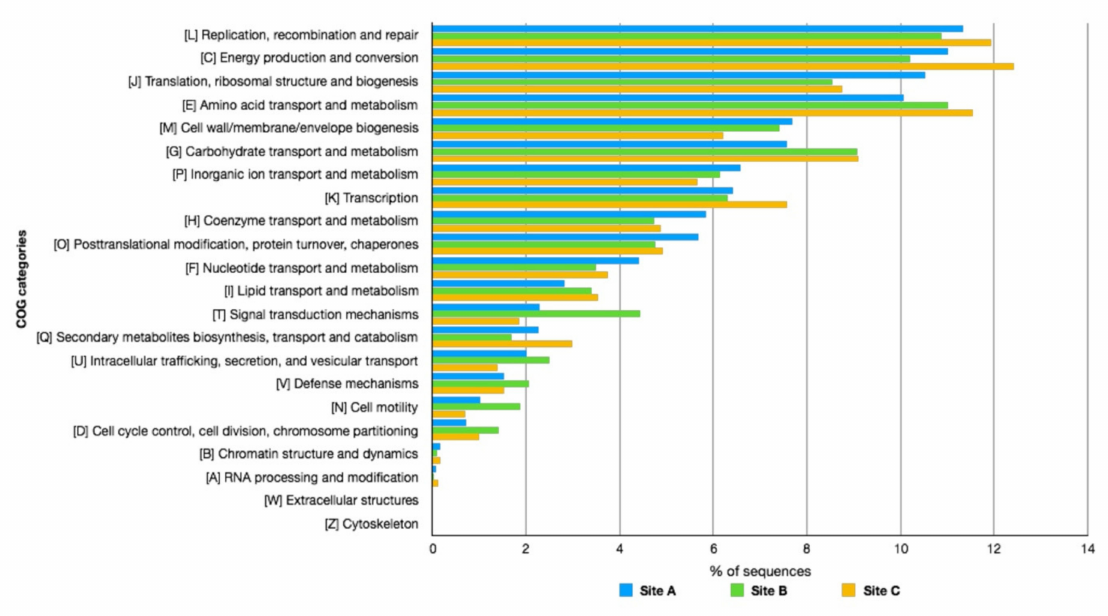
Figure 6. COG analysis of the metagenomes in Pisciarelli hot springs. Sites A, B, and C are compared according to COG functional categories.